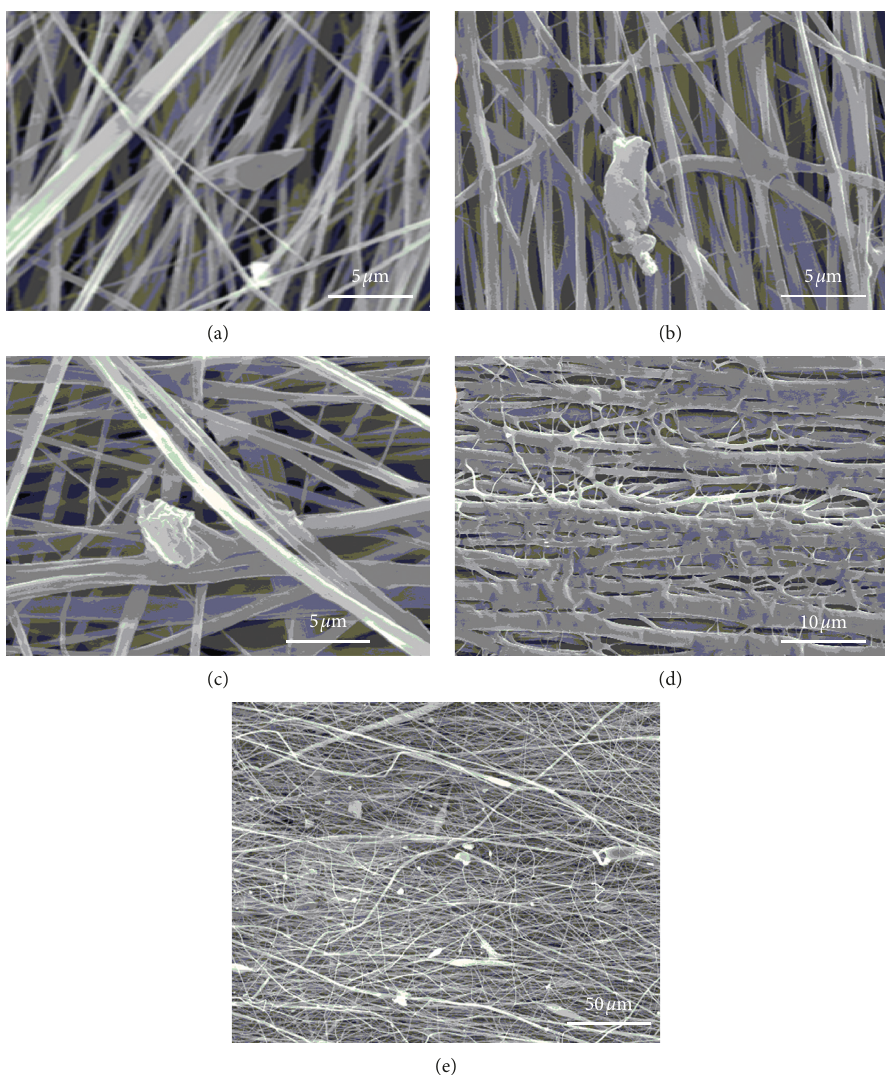
Figure 3: SEM images of (a) PLA-PBC-0.004GO (scale 10 μ m), (b) PLA-PBC-0.01GO (scale 10 μ m), (c) PLA-PBC-0.04GO (scale 10 μ m), (d) PLA-PBC (scale 10 μ m), and (e) PLA-PBC-0.01GO (scale 100 μ